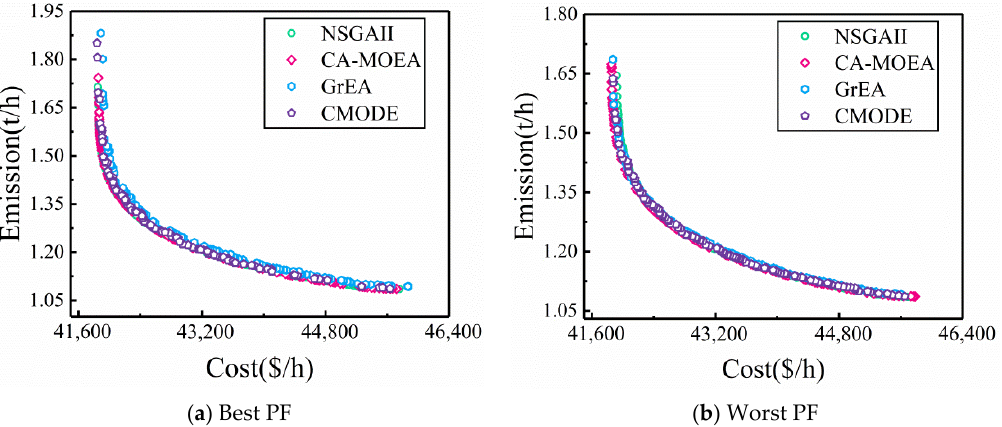
Figure 6. The comparison of the PFs of all methods in case 1.